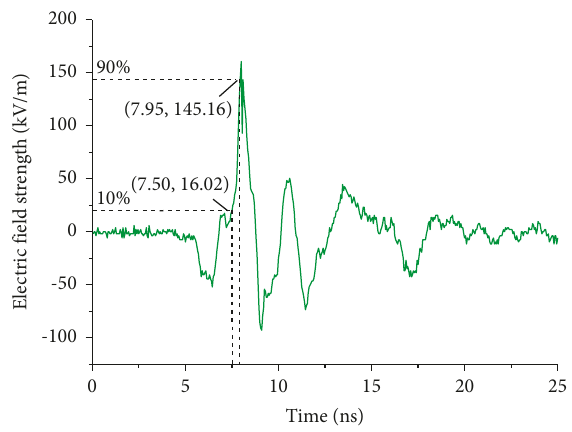
Figure 2: The time-domain waveform of UWB